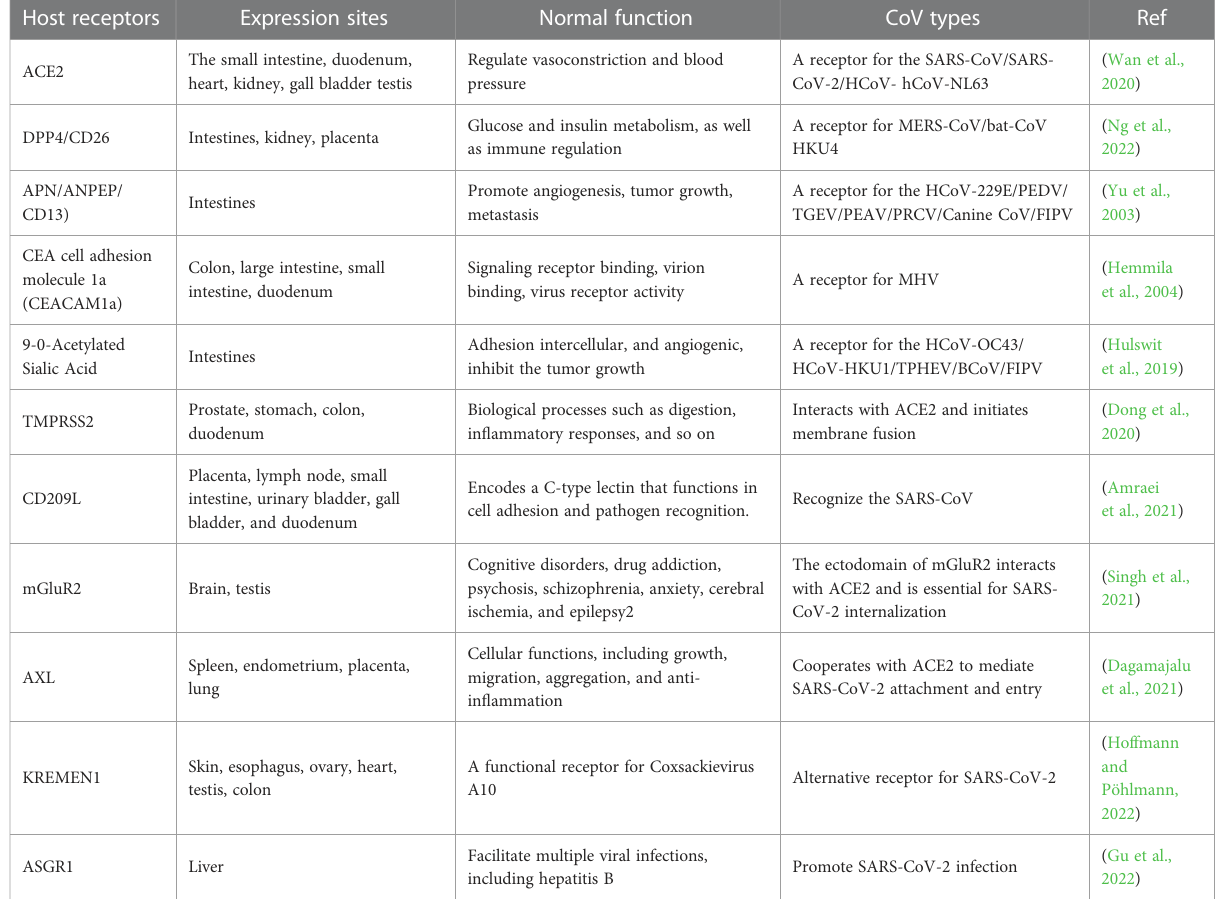
TABLE 1 Characteristics of host cellular receptors for various